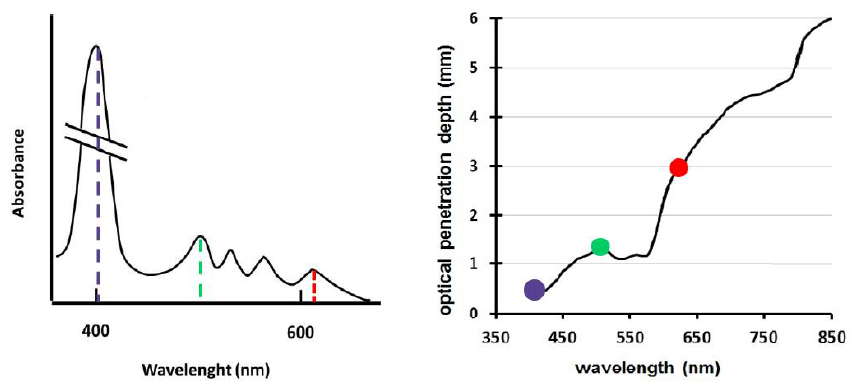
Figure 2. Left : absorption spectrum of the endogenous porphyrins of H. pylori . Right : depth of penetration of visible light inside the gastric mucosa.